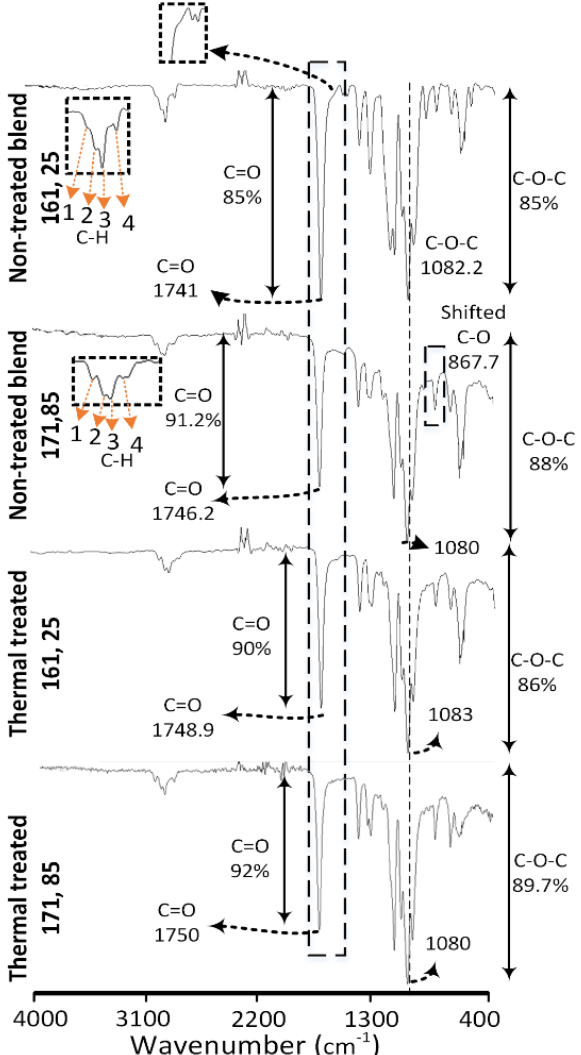
Figure 5. FTIR analysis for post 3d printing thermal treatment (thermal aging).